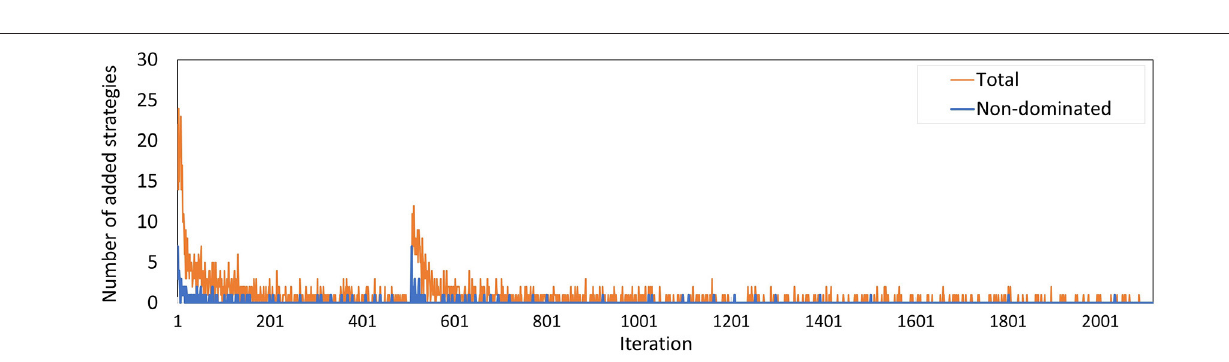
personalized policies have a fixed stopping age of 85 by design. Disregarding these two reference policies, the QALYs of the obtained screening policies were up to 4.3% higher than the QALYs of the reference policies for similar